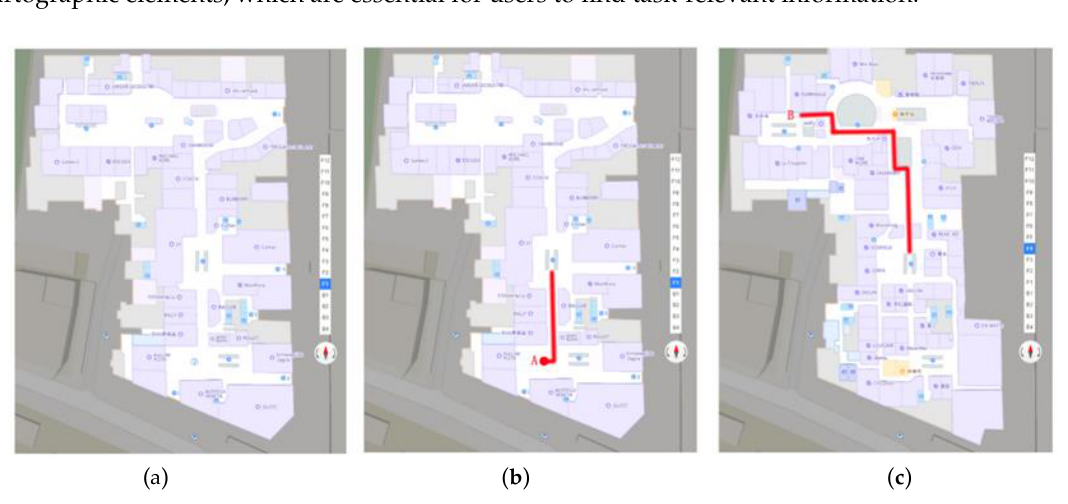
Figure 2. Indoor map for wayfinding: ( a ) Indoor map of the 1st floor for Task 1, Routes of 1st floor ( b ) and 4th floor ( c ) for Task 2 and Task 3.